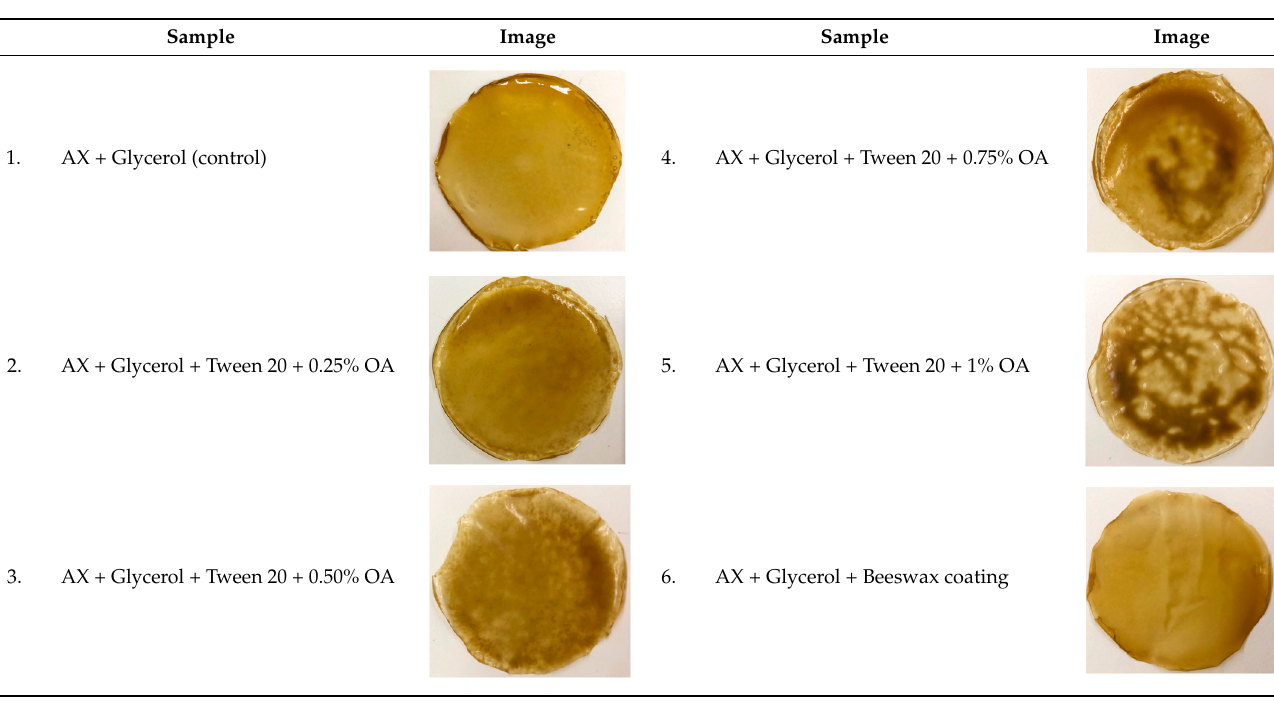
Table 3. Visual appearance of composite films.